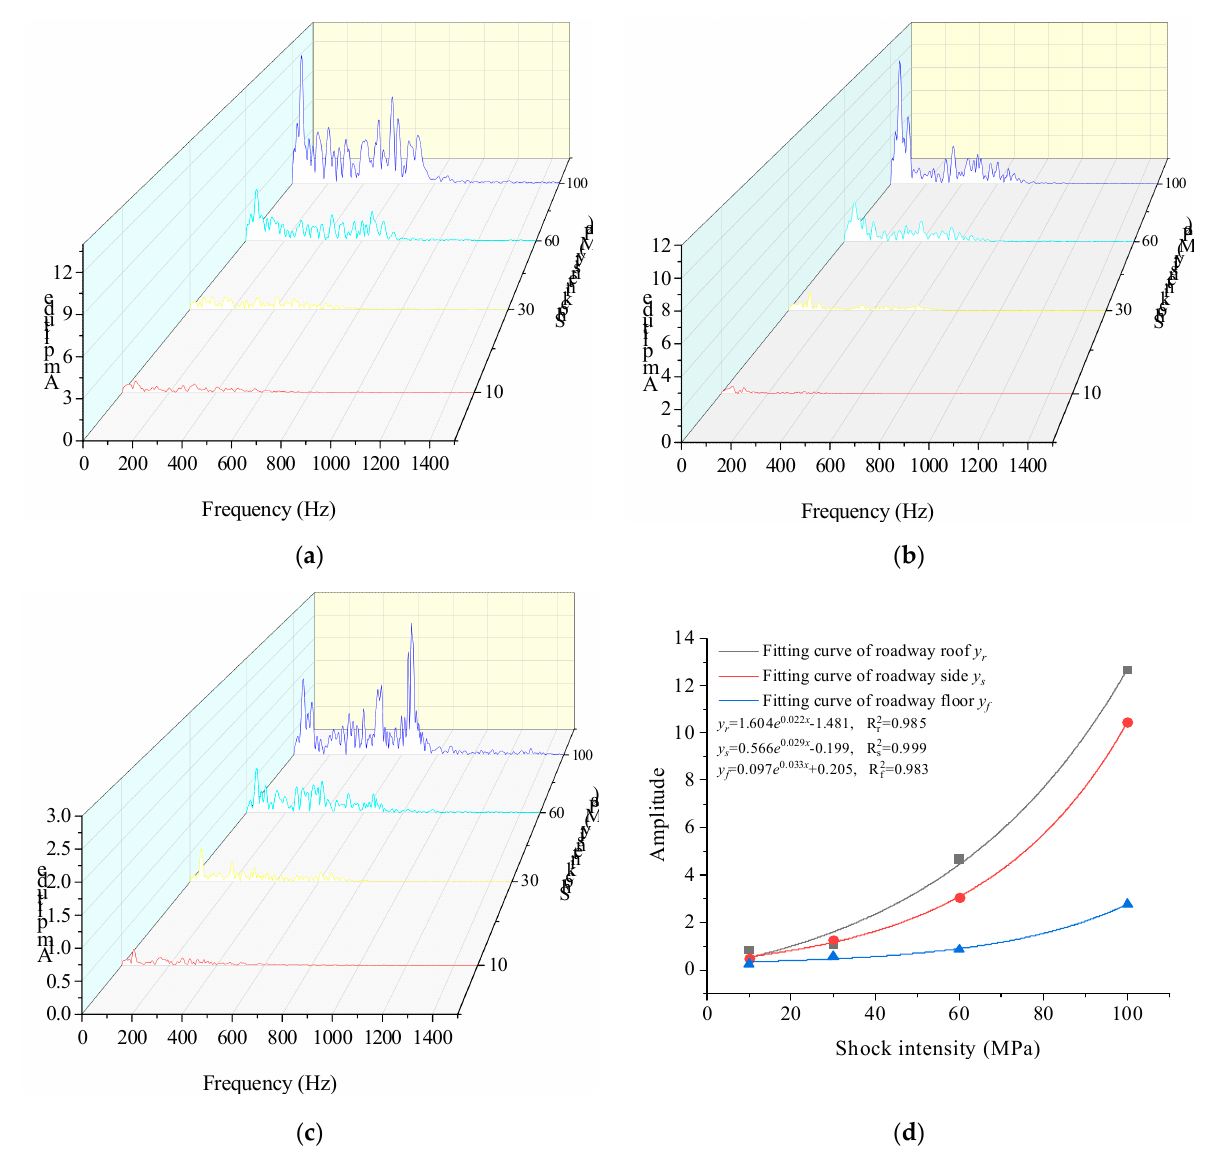
Figure 9. Acceleration frequency − amplitude curve of the surrounding rock of the roadway for different shock intensities. ( a ) Roadway roof; ( b ) roadway side; ( c ) roadway floor; ( d ) maximum amplitude fitting curve.